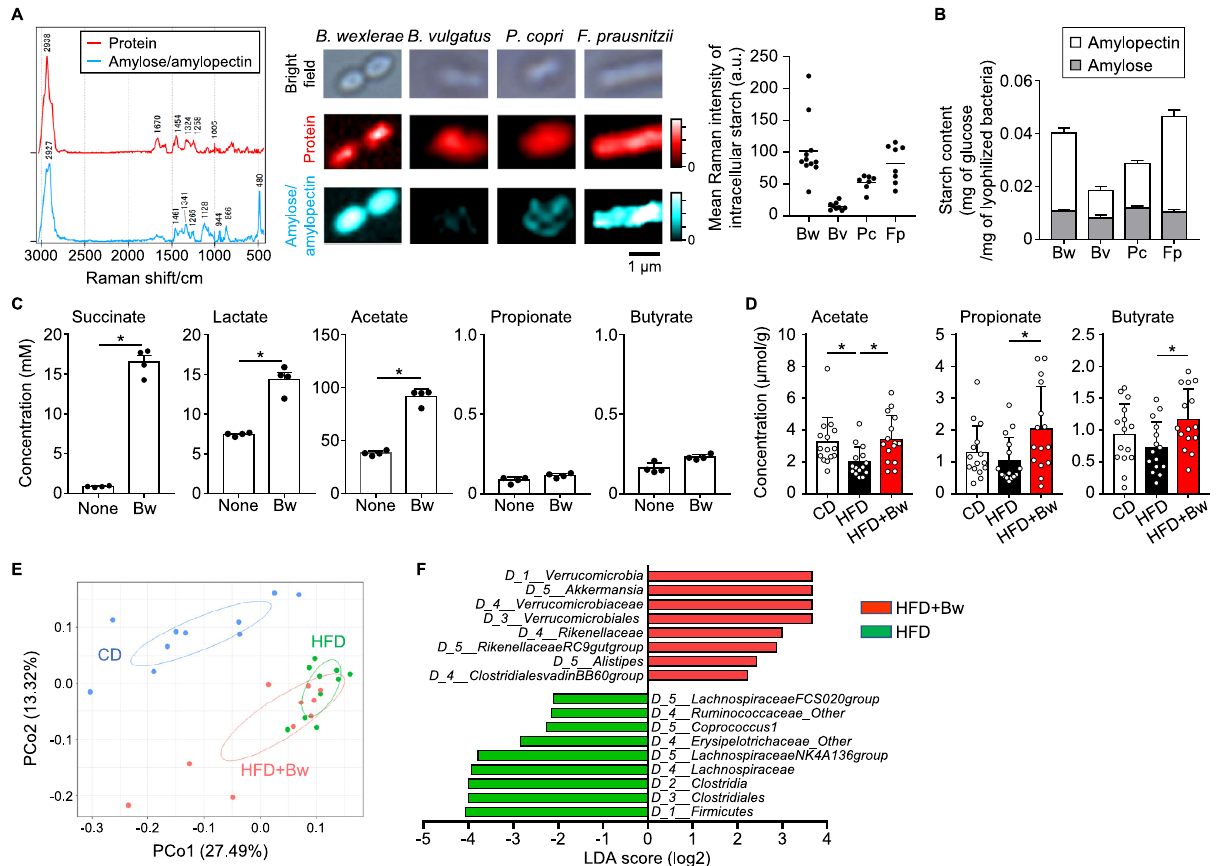
Fig. 5 | Administration of B. wexlerae altered the intestinal environment, including gut bacterial composition and fecal short-chain fatty acid (SCFA) content,in mice.A Ramanspectroscopicanalysis. Raman shift signals speci fi c for protein and starch were plotted on bacterial cells of B. wexlerae (Bw) and major intestinal bacteria including Bacteroide vulgatus (Bv), Prevotella copri (Pc), and Faecalibacterium prausnitzii (Fp). a.u., arbitrary units. B Starch (amylose and amy- lopectin) contents in B. wexlerae (Bw) and major intestinal bacteria, including B. vulgatus (Bv), P. copri (Pc), and F. prausnitzii (Fp). Data are representative of two independent experiments ( n =4 biologically independent samples, mean ± 1SD). C The concentrations of succinate, lactate, acetate, propionate, propionate, and butyrateinfreshmedium(none)and B.wexlerae culturesupernatant(Bw).Dataare representative of two independent experiments ( n =4, mean ± 1SD). * P =0.0286 (two-tailed Mann – Whitney U test). D SCFA content in fecal samples from mice.